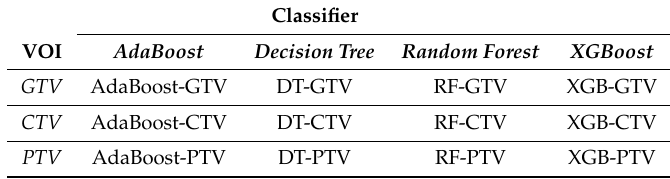
Table 2. Overview of all possible combinations of volume of interests (VOIs) and learning